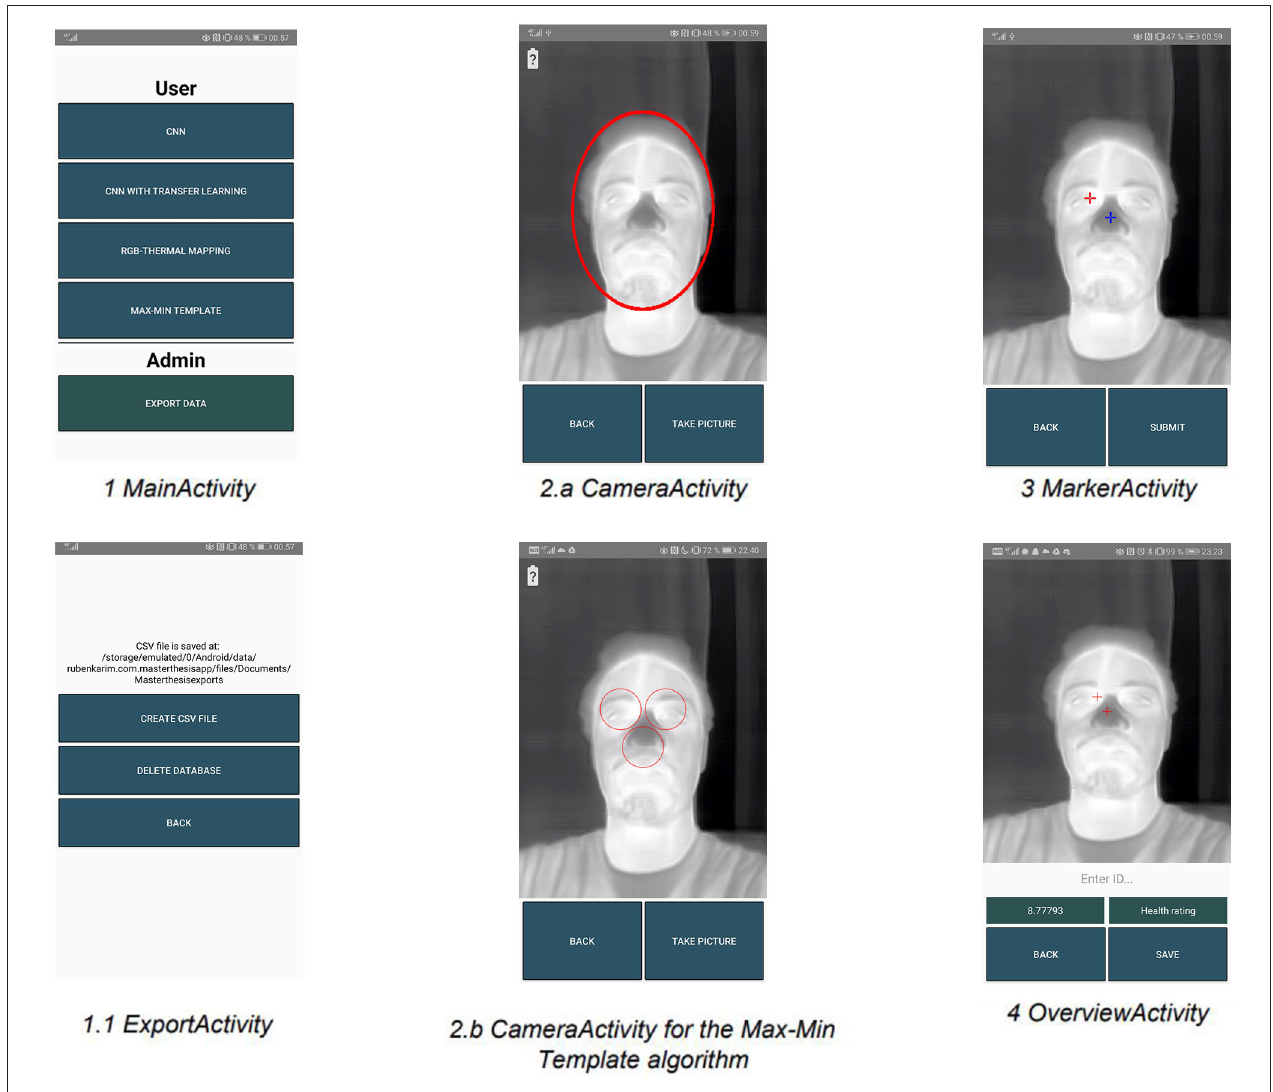
FIGURE 9 | Overview of all the views in the android application.